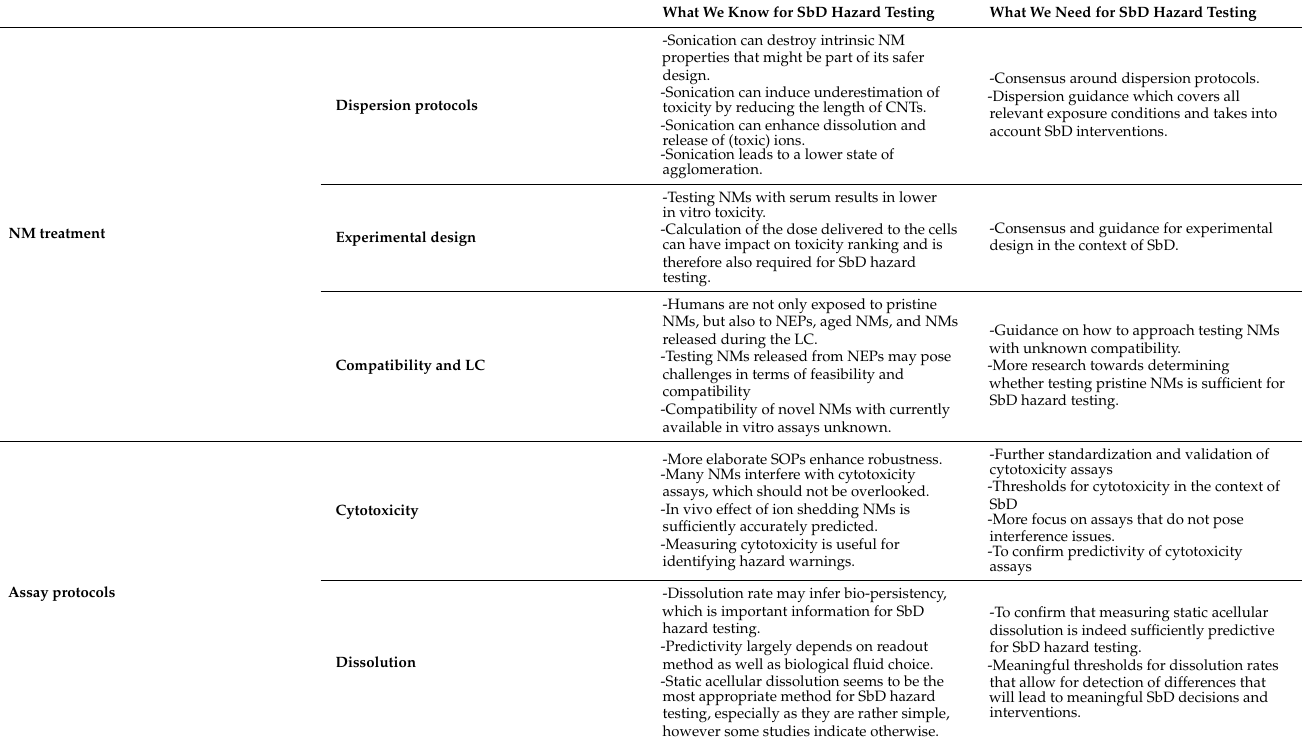
Table 6. Overview of the most important findings in this review, including knowns and needs for SbD hazard